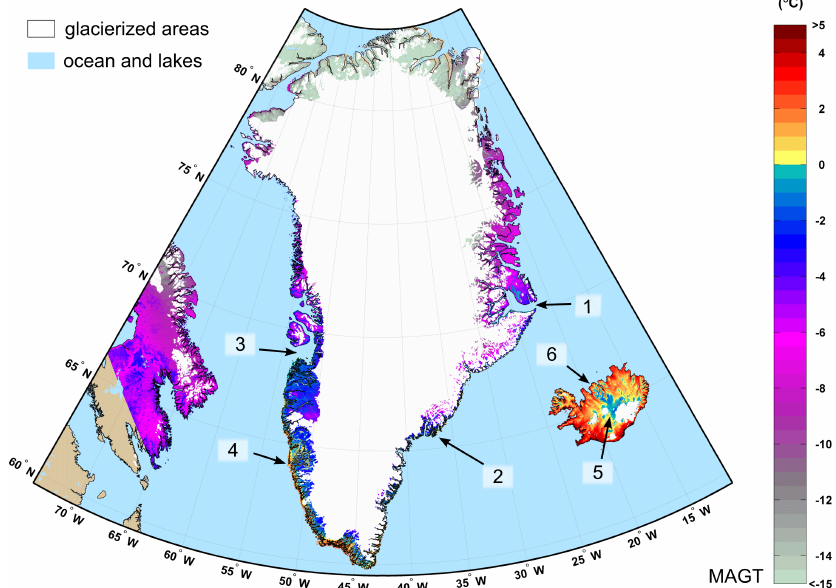
Figure 6. Average MAGT of all model realizations for Greenland and Iceland. 1: Scoresby Sound; 2: Tasilaq region; 3: Disko Bay; 4: Nuuk region; 5: Sprengisandur; 6: Tröllaskagi Peninsula. Glacierized areas from Natural Earth (www.naturalearthdata.com).